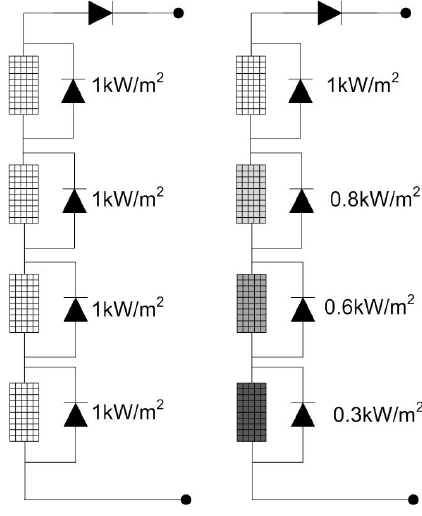
Figure 3. Cases of uniform irradiance and partial shading.